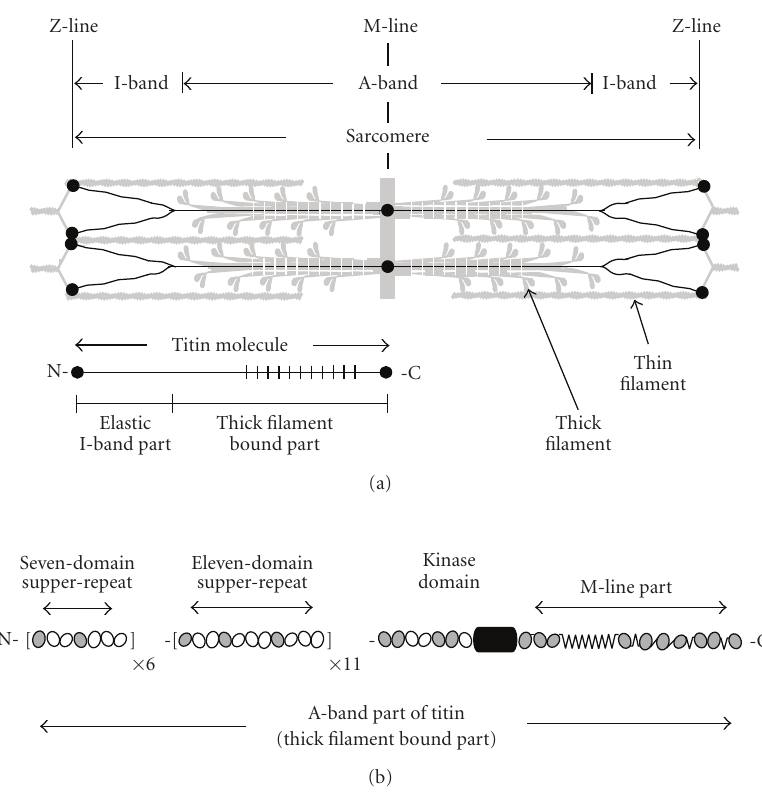
Figure 1: Schematic representation of titin layout in the sarcomere (a) and of the domain periodicity in the thick filament bound part (b). Striated zones in the sarcomere and the titin molecule (a) show the location of the large